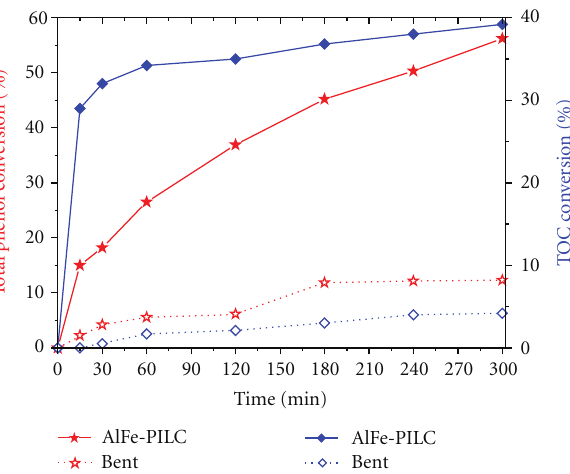
Figure 2: Phenolic acids conversion with AlFe-PILC.